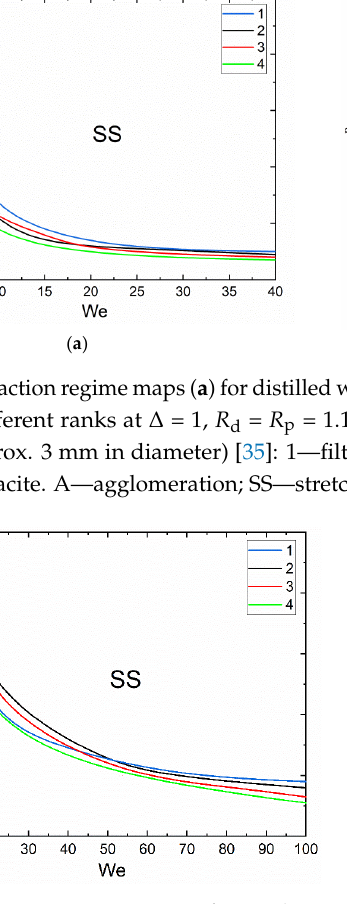
Figure 10. Interaction regime maps for used motor oil droplets colliding with carbonaceous particles of coals of different ranks at Δ = 1, R d = R p = 1.1 – 1.2 mm: 1 — filter cake of coking coal; 2 — brown coal; 3 — coking coal; 4 — anthracite. A — agglomeration; SS — stretching separation. At Δ = 1 and R d = R p = 1.1 – 1.2 mm, stretching separation dominated agglomeration